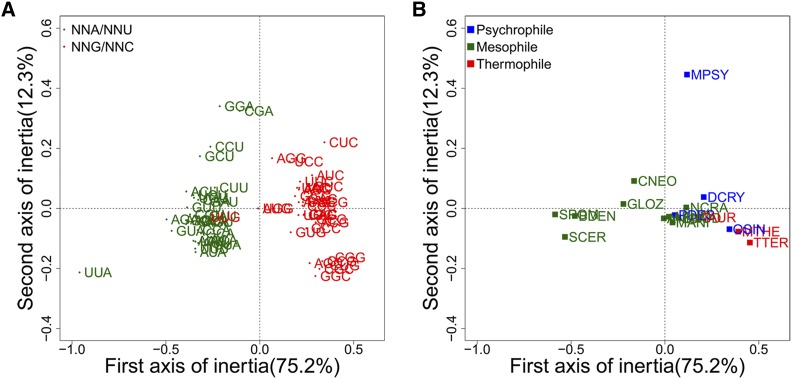
Correspondence analysis of the relative synonymous codon usage from 15 fungal genomes. (A) The distribution of synonymous codons along the first and second axes of the correspondence analysis. Codons ending in A or U are shown in green and codons ending in G or C are shown in red. (B) The distribution of species along the first and second axes of the correspondence analysis. Psychrophiles are shown in blue, mesophiles are shown in green, and thermophiles are shown in red.